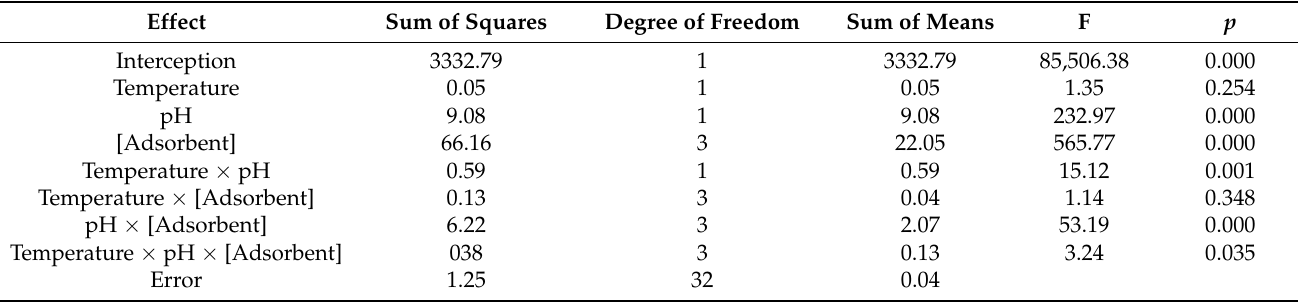
Table 3. ANOVA for the optimization of the best biosorption